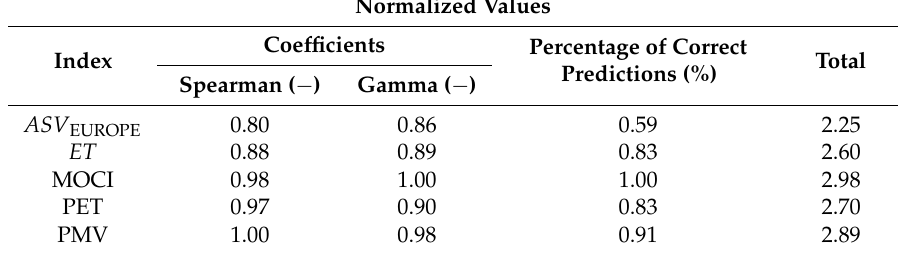
Table 4. Total percentage of correct predictions and correlation coefficient between the values predicted by the indices and votes given by the interviewees normalized with respect to the maximum value of each